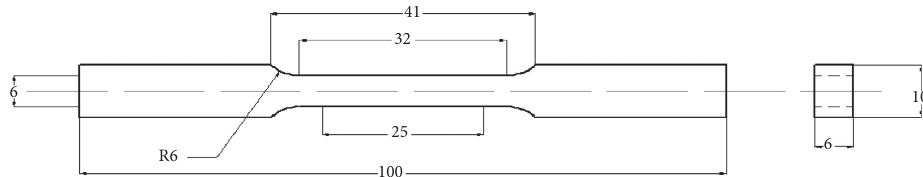
Figure 3: Tensile samples (mm).